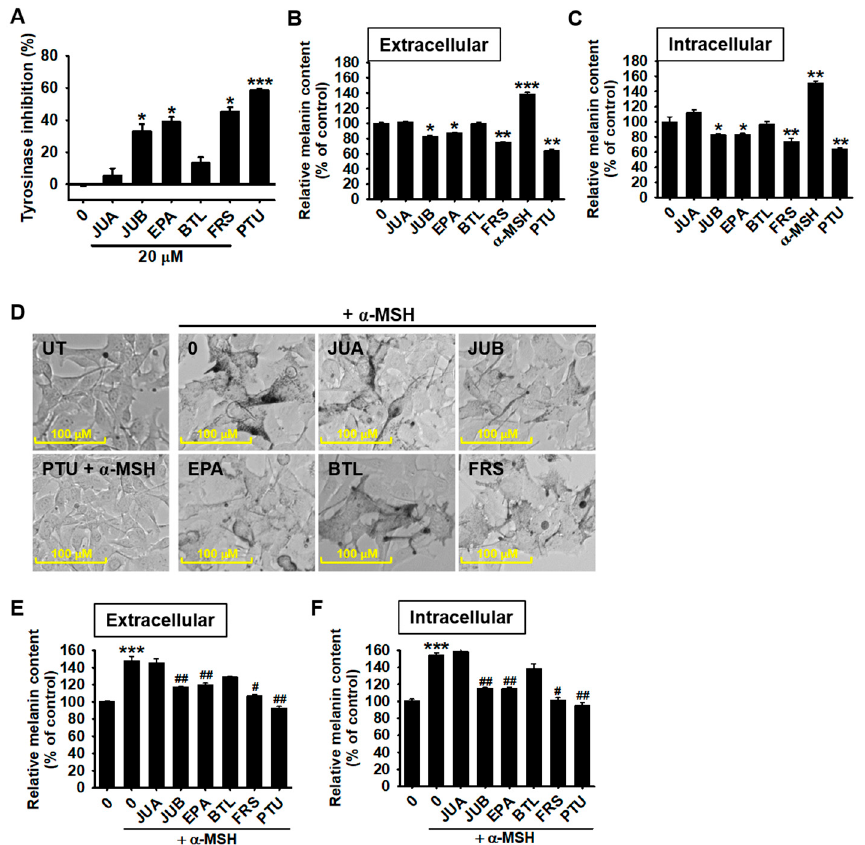
Figure 3. JUB, BTL, and FRS from Z. jujuba var. inermis (Bunge) Rehder seeds inhibit in vitro tyrosinase activity and melanin production in B16F10 melanoma cells. ( A ) In vitro mushroom tyrosinase enzyme activity in the presence of 20 µM of jujuboside A (JUA), jujuboside B (JUB), epiceanothic acid (EPA), betulin (BTL), and 6’’’-feruloylspinosin (FRS) was determined by oxidation of L-tyrosinase as a substrate. Phenylthiourea (PTU, 200 nM) was used as a positive control. B16F10 murine melanoma cells (5 × 10 4 cells/mL) were treated with 20 µM of JUA, JUB, EPA, BTL, and FRS for 96 h in the ( B , C ) absence and ( D – F ) presence of 500 ng/mL of α -melanocyte-stimulating hormone ( α -MSH). Intracellular and extracellular melanin was quantified. PTU was used as a negative